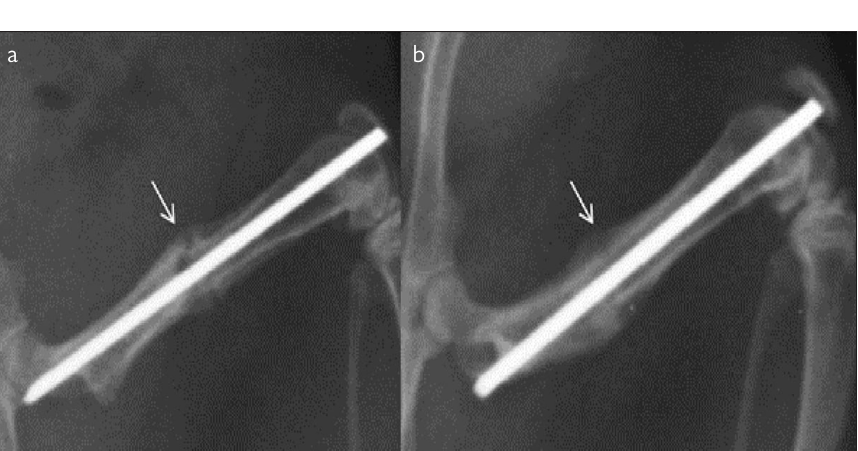
Figure 2. a, b. (a) Fracture control, (b) Ebselen treatment